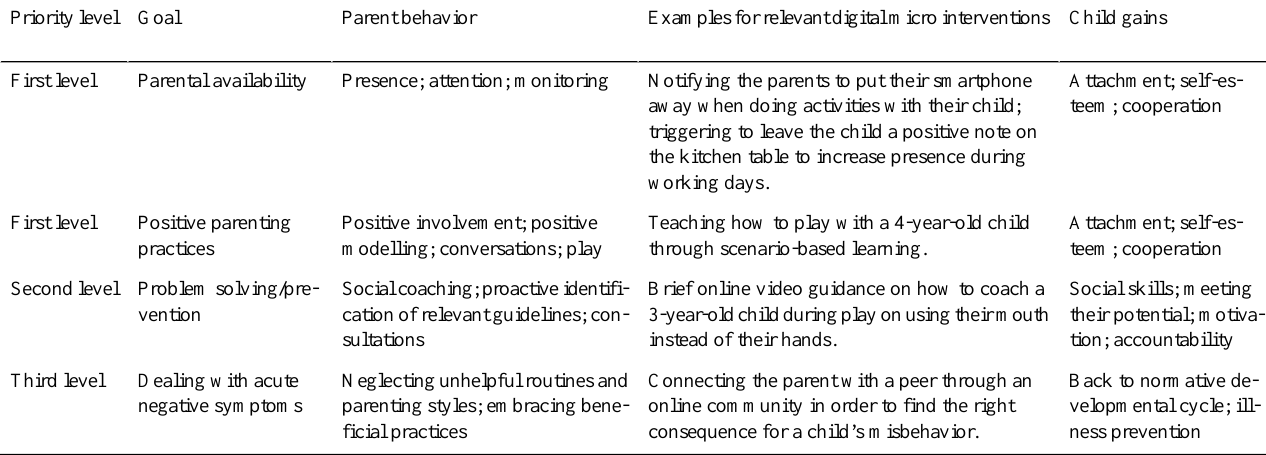
Table 3. An example for a model defining the capabilities parents are required to present in order to prevent behavior problems and promote social and emotional